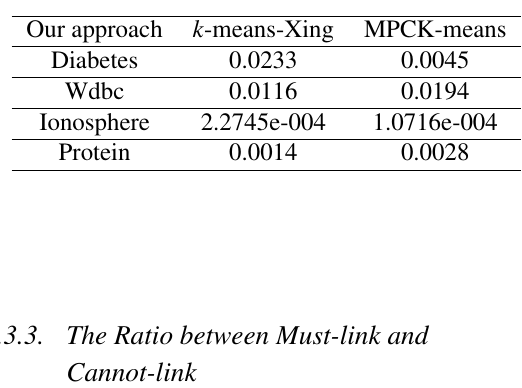
Fig. 7. Clustering accuracy versus constraints on Protein